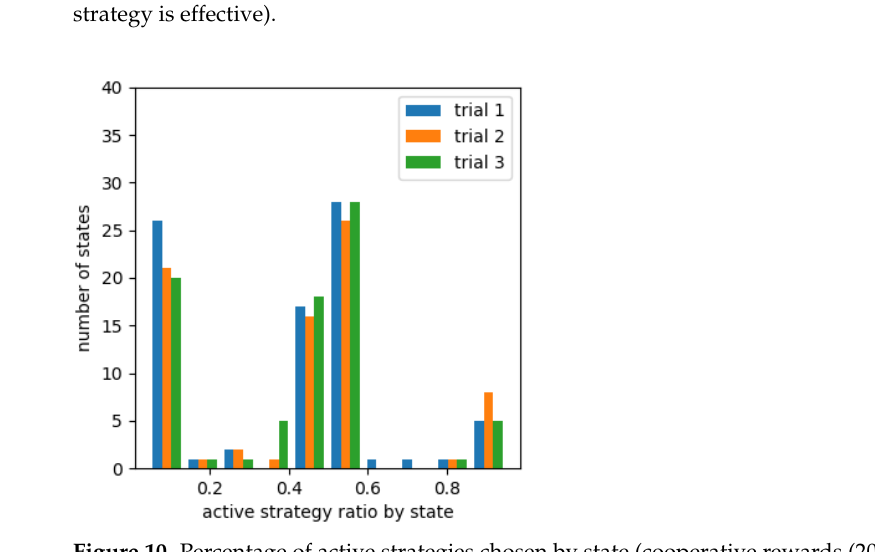
Figure 10. Percentage of active strategies chosen by state (cooperative rewards (20, 10), after passive strategy is effective).